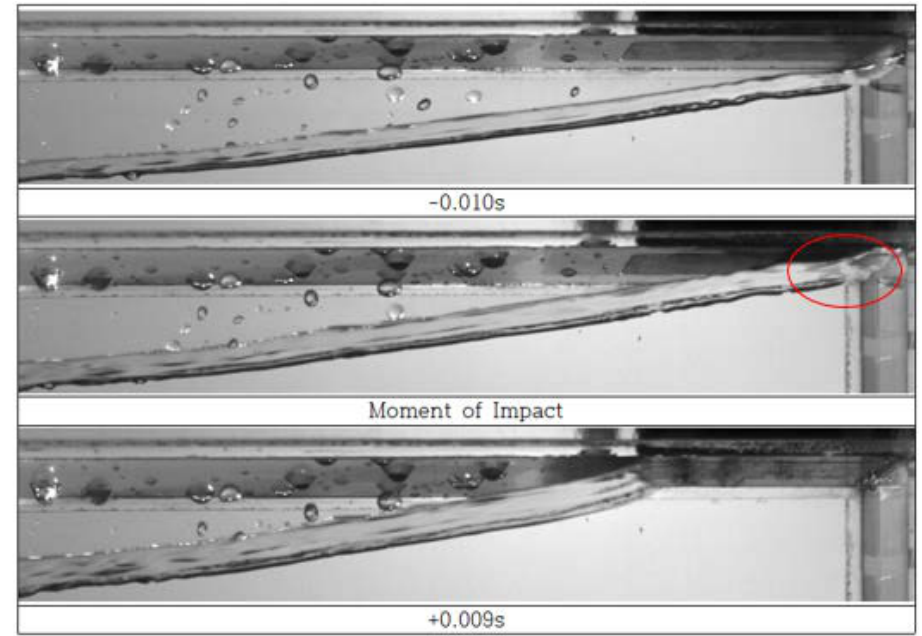
Figure 14. Snapshots at First Impact: ROLL (Dry).